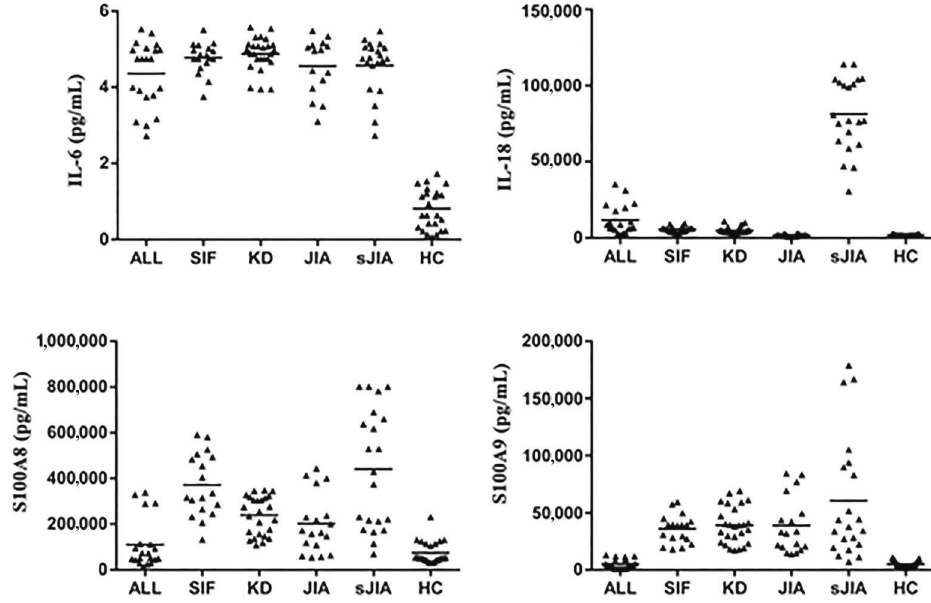
Figure 1. Concentrations of serum markers of all patients. Data are reported as means ± SD. IL: interleukin; ALL: acute lymphoblastic leukemia; SIF: severe infections; KD: Kawasaki disease; JIA: juvenile idiopathic arthritis; sJIA: systemic-onset JIA; HC: healthy curve (AUC) of IL-18, S100A8, and S100A9 was greater from ALL. Among the markers, IL-18 showed a maximum than 90%, which suggested a remarkable sensitivity and AUC of 0.995, indicating a relatively better predictive speci fi city of these three biomarkers in differentiating sJIA value. When comparing sJIA to SIF, the AUC of IL-18 was 1.